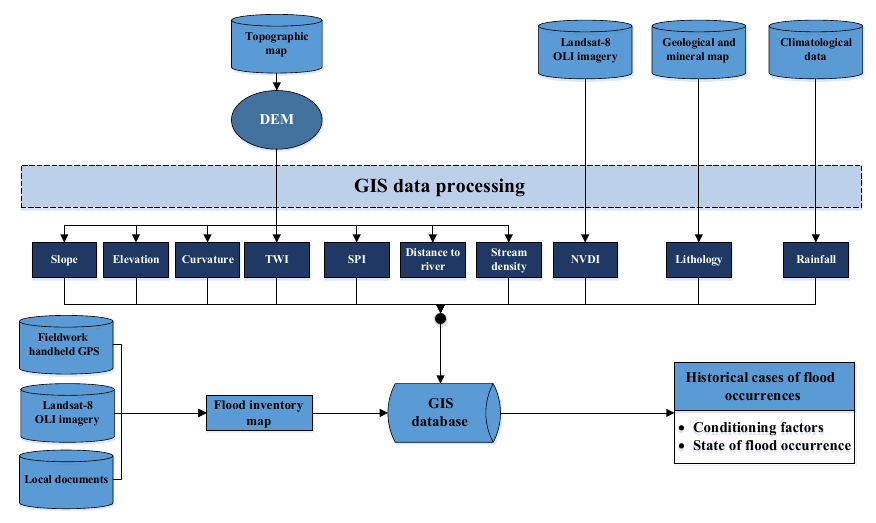
Figure 5. The established GIS